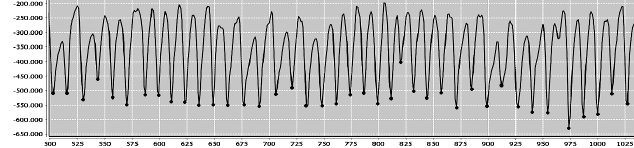
adjusted with parametric coefficients to specify the amplitude range in which a candidate must fall.